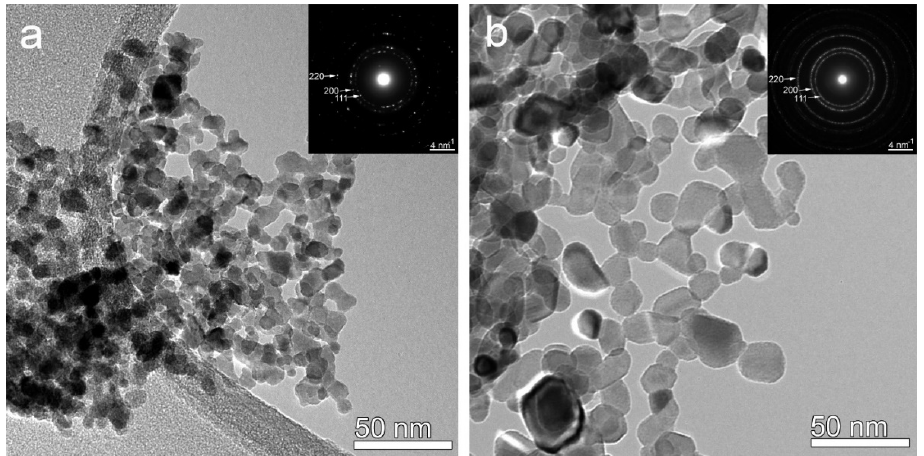
Figure 3. TEM images and the associated SAED patterns (inserted) of the as-prepared NiO nano- particles for the samples calcinated at 400 °C ( a ) and 500 °C ( b